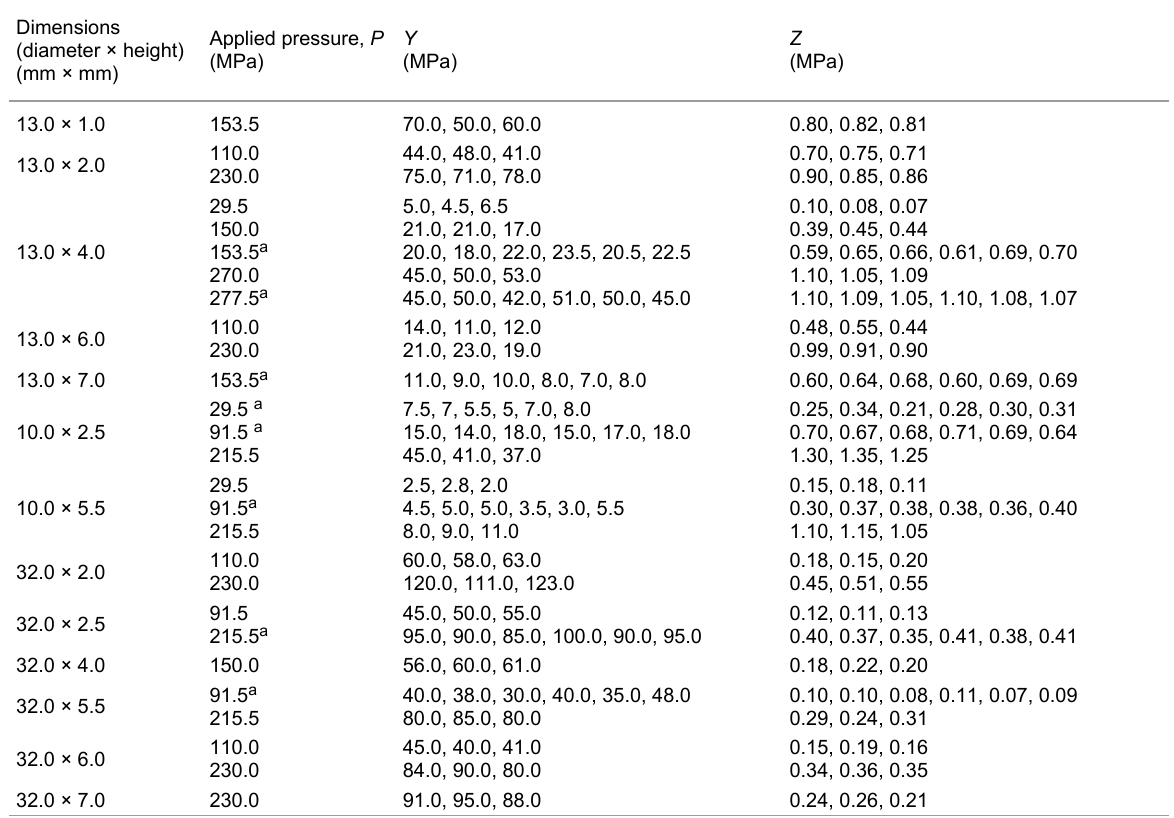
Table 1: Experimental tests (3 or 6 repeated tests) to study the influence of three parameters (diameter, height and applied pressure) on the ultimate compressive strengths of the final pellets. Y is the uniaxial ultimate compressive strength and Z is the diametric ultimate compressive strength. Dimensions (diameter × height)